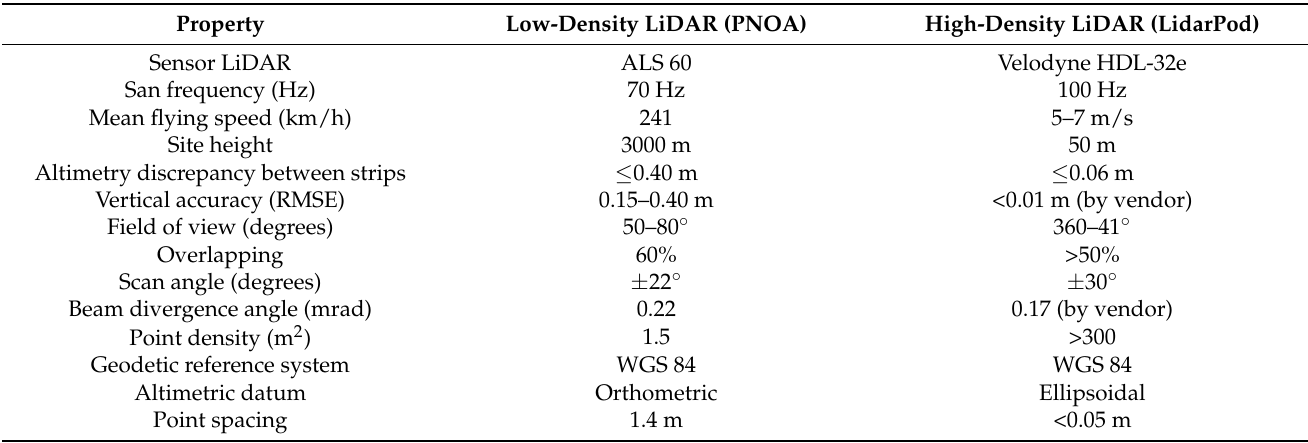
Table 2. Technical characteristics of sites and operation of the low-density LiDAR (PNOA) and high-density LiDAR (LidarPod)